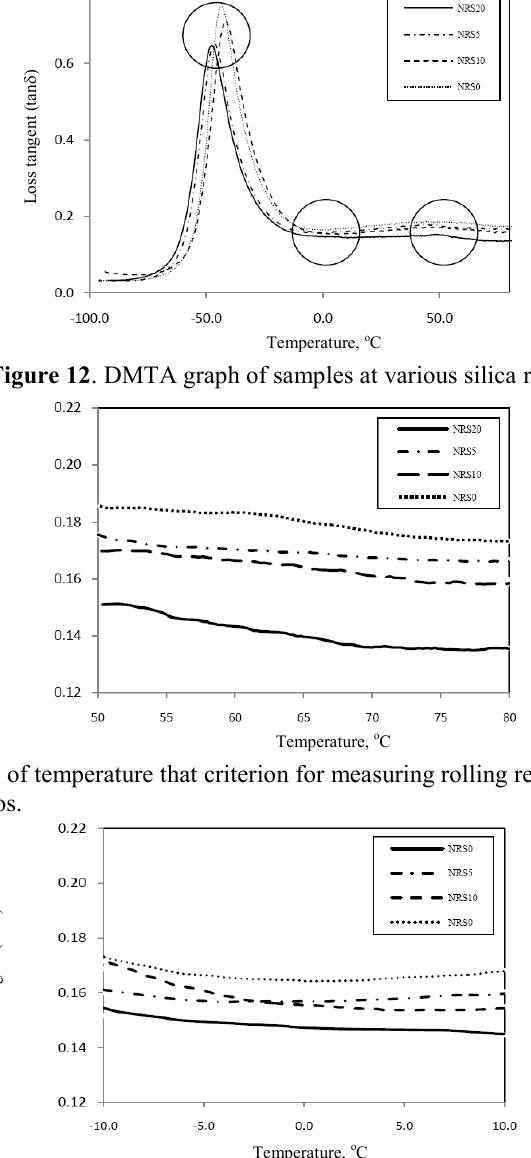
Figure 14. Range of temperature that criterion for measuring wet grip of samples at various silica